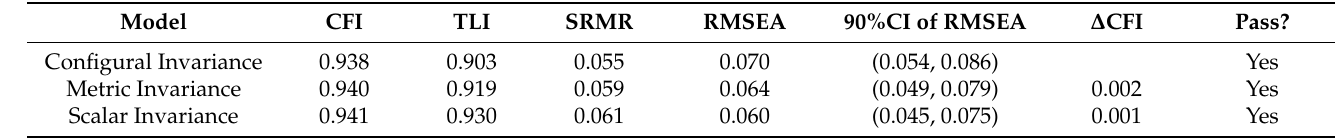
Figure 1. Multiple mediation model. Note: * p < 0.05, ** p < 0.01. The solid lines represent significant path coefficients, and the bold solid lines indicate the mediation effects. The dotted lines represent non-significant path coefficients. Table 5. Measurement invariance of RSE.